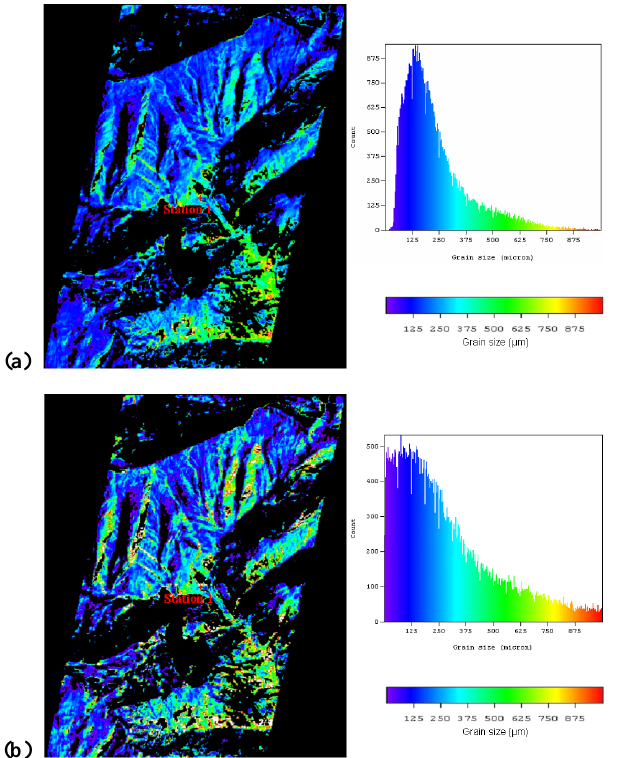
Fig. 6. The spatial distribution of snow grain size retrieved using (a) 1240nm and (b) 1050nm by Hyperion data for a part of lower Himalaya.